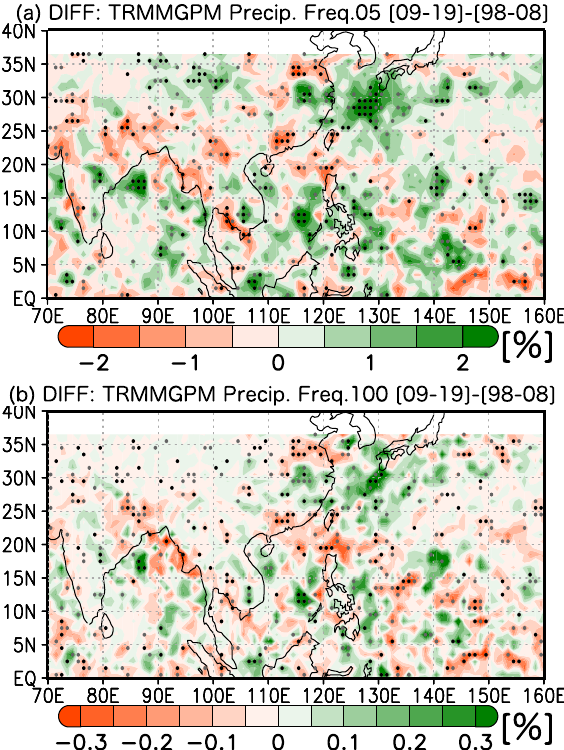
Figure 2. Twenty-two-year changes in frequency of Meiyu–Baiu rainfall (i.e. the differences between the two 11-year periods), with statistical significance shown by black and grey dots, which denote 95% and 90% confidence intervals, respectively. Precipitation was counted when the rainfall rate exceeded the threshold value (( a ) : 0.5 mm/h, ( b ): 10 mm/h). For definition and plotting, see Methods. Figure generated with GrADS 2.2.1 (http:// cola. gmu. edu/